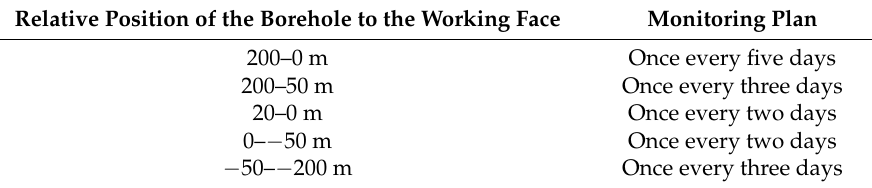
Table 1. Borehole monitoring plans.